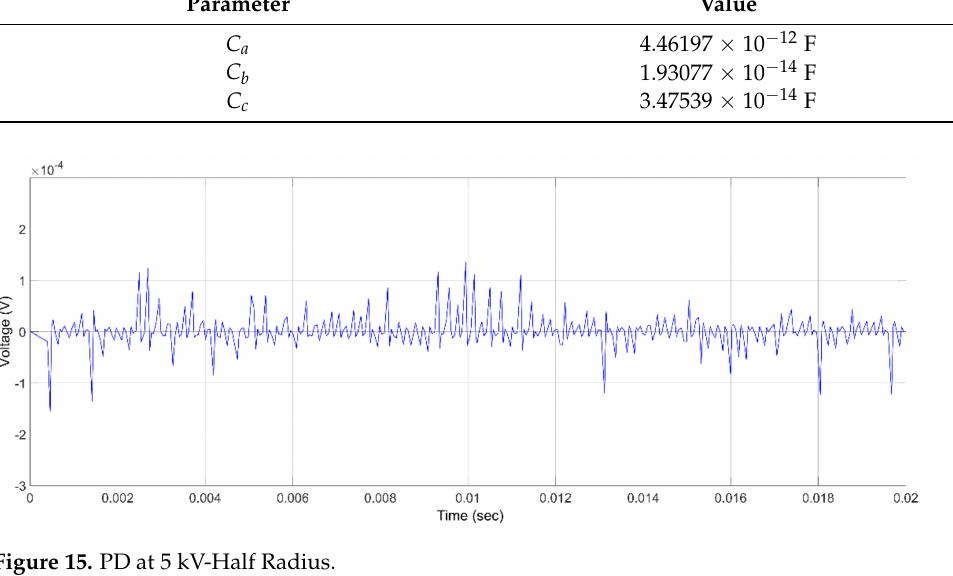
Figure 15. PD at 5 kV-Half Radius.